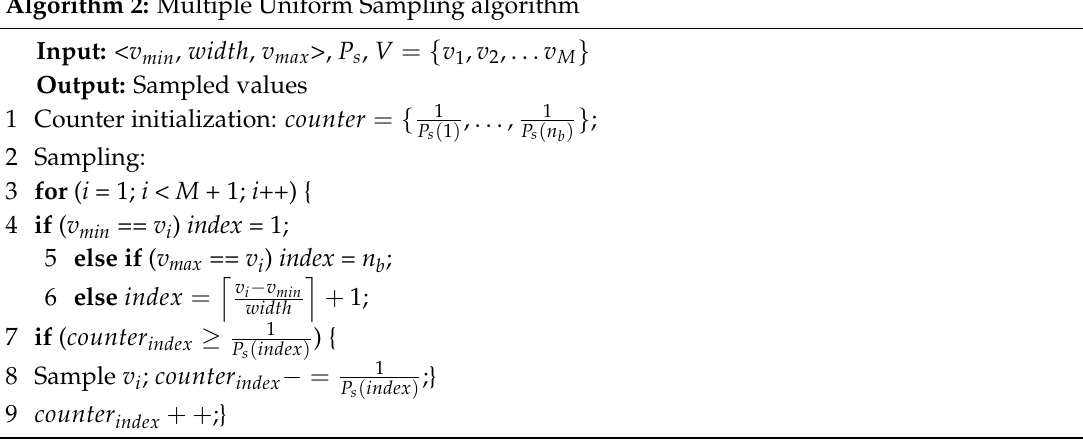
Algorithm 2: Multiple Uniform Sampling